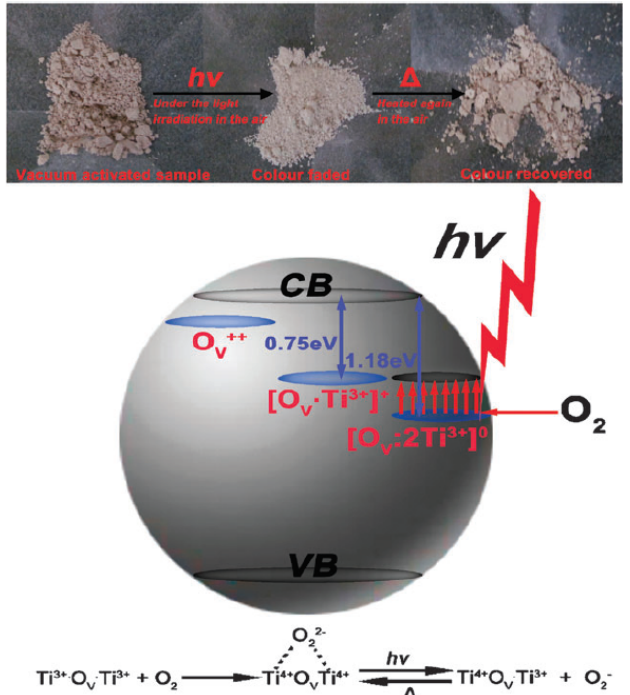
Figure 6. Band structure model and color changing for vacuum activated TiO 2 and the illustration of its photosensitive property in the air. Reprinted with permission from [75]. Copyright 2011, The Royal Society of Chemistry.